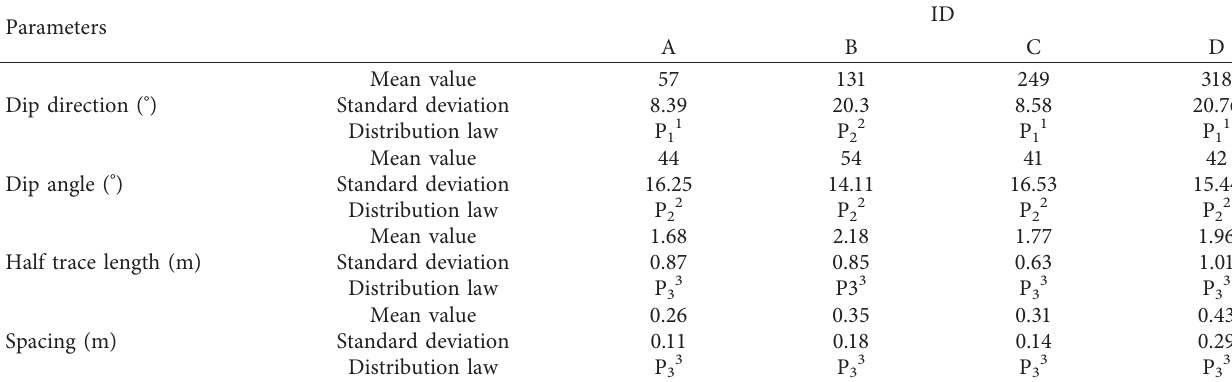
Table 2: The basic parameters and distribution for dominant orientations.